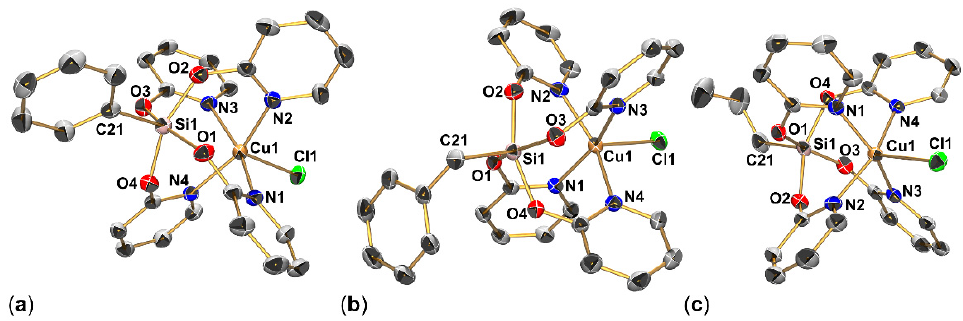
Figure 10. Molecular structures of ( a ) 3b , ( b ) 3c and ( c ) 3d with thermal displacement ellipsoids at the 50% probability level and labels of selected non-hydrogen atoms. Hydrogen atoms are omitted for clarity. Selected interatomic distances and angles are listed in Table 3. Table 3. Selected atom distances (Å) and bond angles (deg) in compounds 3b , 3c and 3d in their crystal structures (as well as some corresponding parameters of 3a [20]).